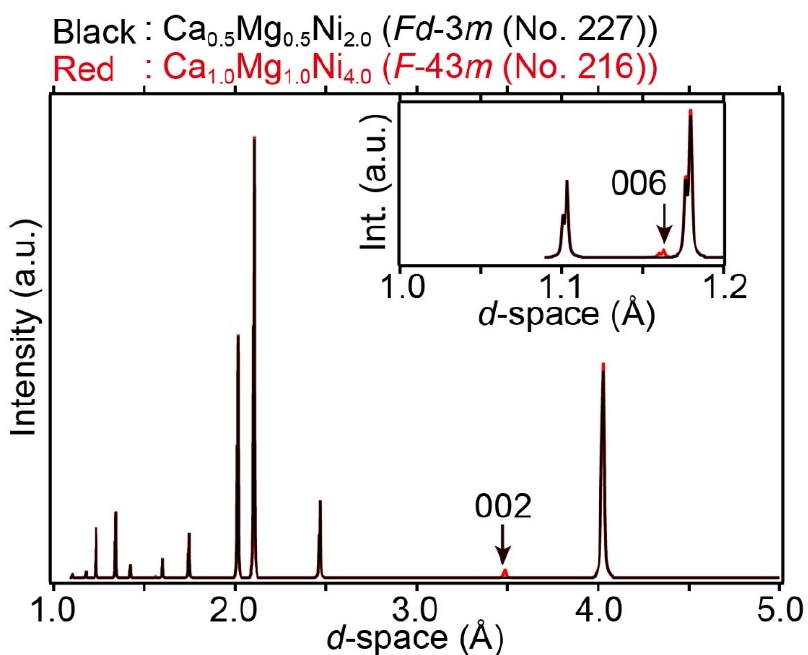
Figure 2. Simulated X-ray diffraction patterns of (black) Ca 0.5 Mg 0.5 Ni 2.0 in the space group Fd -3 m (No. 227) and (red) hypothetical Ca 1.0 Mg 1.0 Ni 4.0 in the space group F -43 m (No. 216). For the simulation, Cu K α radiation (wavelength λ = 1.5406 and 1.5444 Å for K α 1 and K α 2, respectively) was used. For the simulation, unit cell parameters of (Ca, Mg)Ni 2 were used [14]. Inset shows an enlarged pattern at 1.0 ≤ d ≤ 1.2 Å of the X-ray diffraction of Ca 0.5 Mg 0.5 Ni 2.0 and Ca 1.0 Mg 1.0 Ni 4.0 . (002) and (006) reflection, which are the systematic absence of the space group Fd -3 m (No. 227), are indicated by arrows.